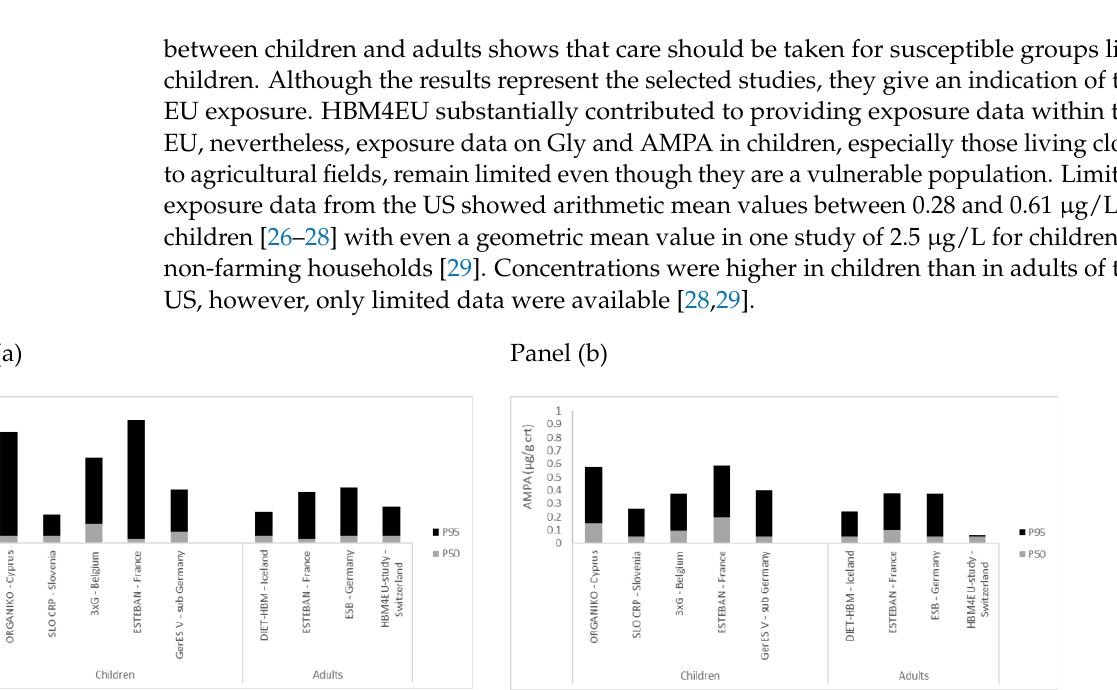
Figure 1. Glyphosate (Gly) and AMPA (µg/g crt) in adults and children of the aligned studies un- der HBM4EU. Panel ( a ) Gly and panel ( b ) AMPA. Data for children described in Buekers et al. 2022 [8]. Values below the LOQ were set at the LOQ/2 for presentation.